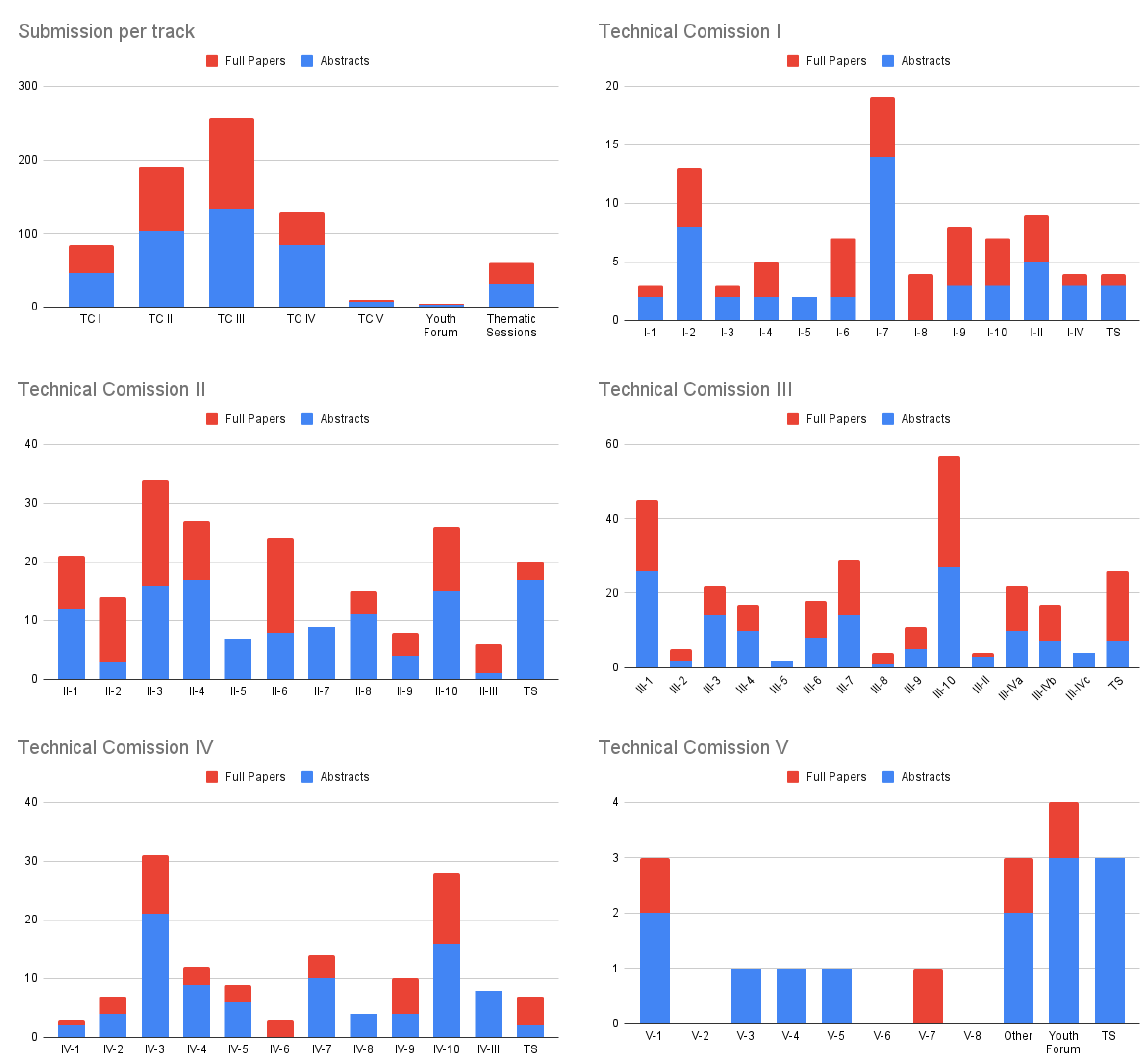
Figure 4. Paper submission